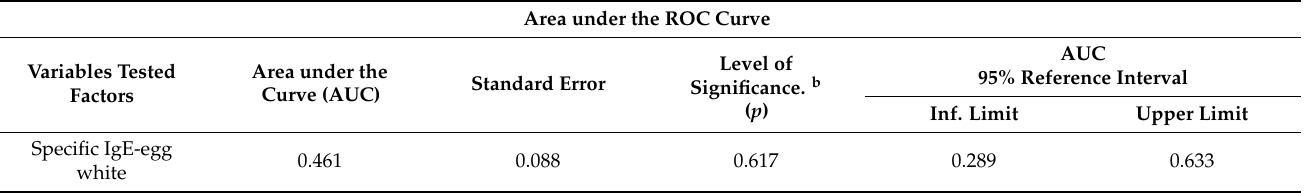
Area under the ROC Curve